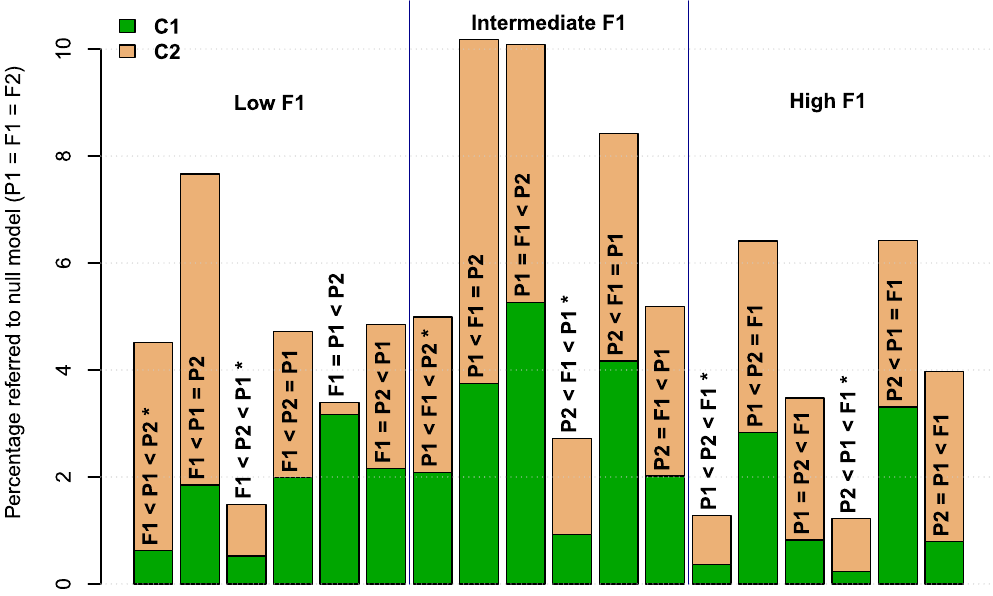
Figure 3. Percentages of sub-models per cross with reference to the total number of null models ( P 1 = F 1 = F 2 ). Sub-model identified in or over each one of the bars. The six main significant sub-models (that contain only inequalities) are identified with an asterisk.